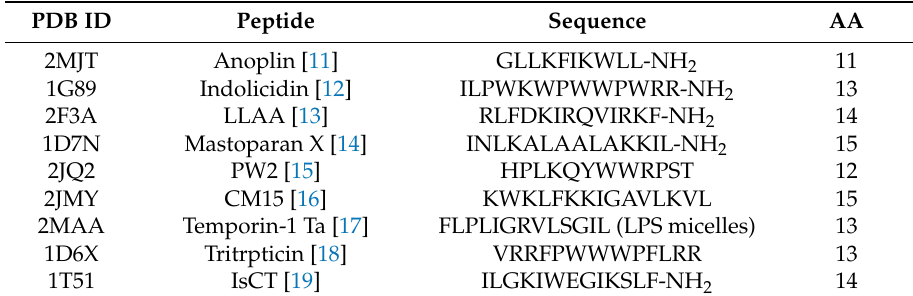
Table 1. Sequences of antimicrobial peptides whose 3D structures were determined in the presence of micelles. For all entries, the NMR data were acquired in the presence of dodecylphosphocholine (DPC) micelles, with the exception of 2MAA which was obtained in presence of lipopolysaccharide (LPS) micelles instead. PDB ID